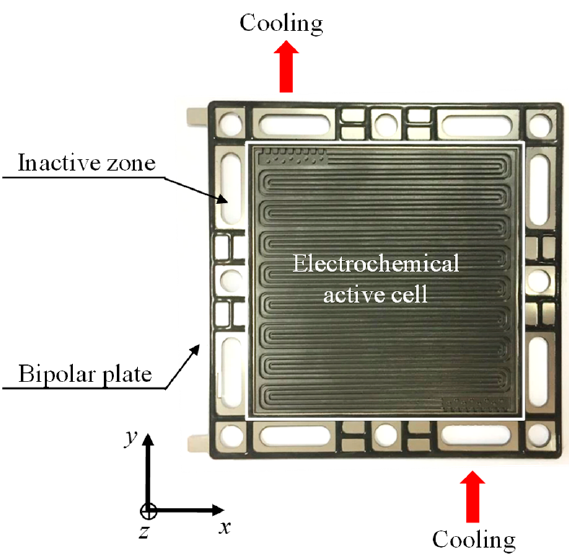
Figure 6. Real bipolar plate of a PEMFC stack. To simulate the (non-)homogeneous distribution of J , this electrochemical active cell is decomposed into Ny × Nx regular conductive segments. For example, the discretization with Ny × Nx = 25 × 20 = 500 conductive segments is considered. This discretization of the electrochemical active cell to study health of the FC is illustrated in Figure